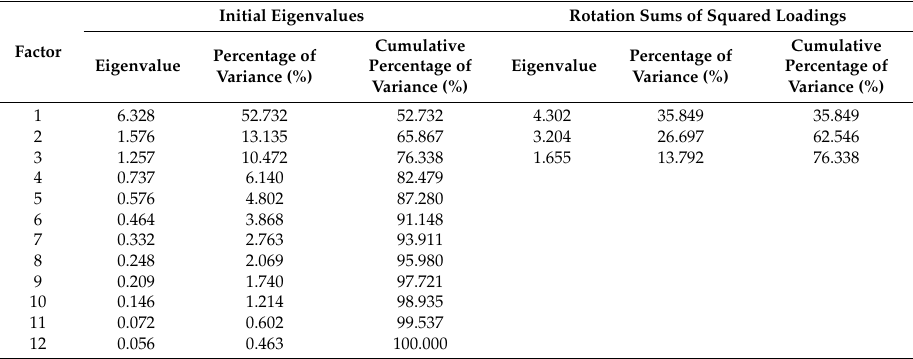
Table 3. R-mode factor analysis: eigenvalues, percentage, and cumulative percentage. Initial Eigenvalues Factor